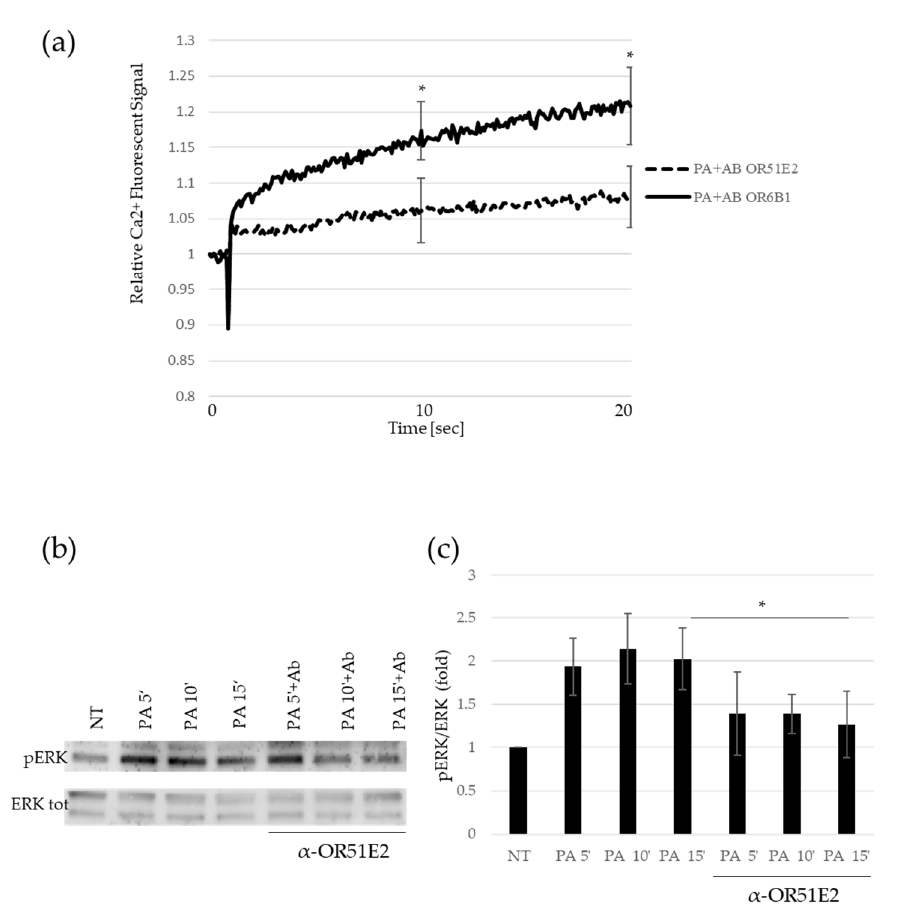
( f ) Histogram shows the ratio of densitometric values of pERK to total ERK in time–course experi- ments of PA treatment. The densitometric value of untreated sperm cells (NT) is arbitrarily set to 1. Mean ± SD of three independent biological replicates are shown (n = 3. * = p < 0.05, one sample t -test). ( g ) Time–course curve of Ca 2+ influx in seminal fluids treated with 50 mM PA or 500 µ M bourgeonal. The fluorescent signal at the time of acute compound injection is set to 1. The fluorescent signals recorded at 10 (middle time point) and 20 s (final time point) are obtained for statistical analysis in comparison to untreated samples (NT). Mean ± SD of six independent experiments are shown (n = 6. ** = p < 0.01, *** = p < 0.001, one sample t -test).